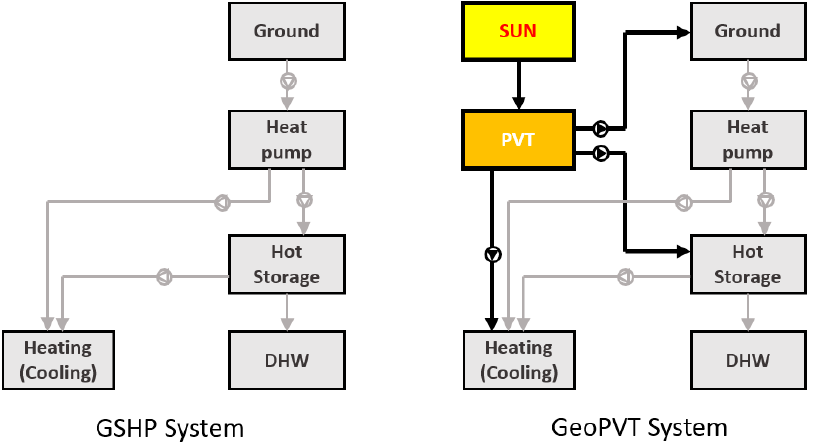
Figure 15. Conceptional design of GSHP system and Geo-PVT system.